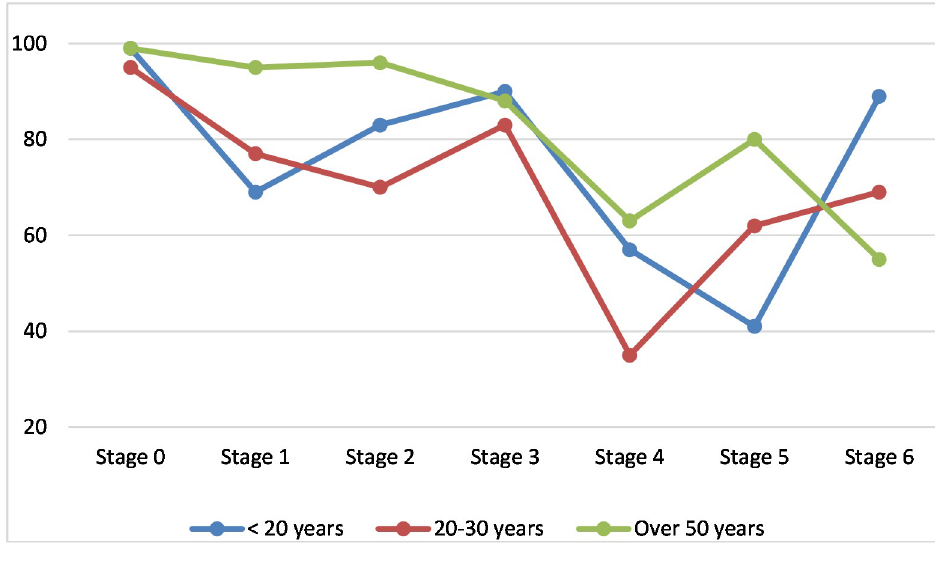
Fig 3. SoC intensity according to